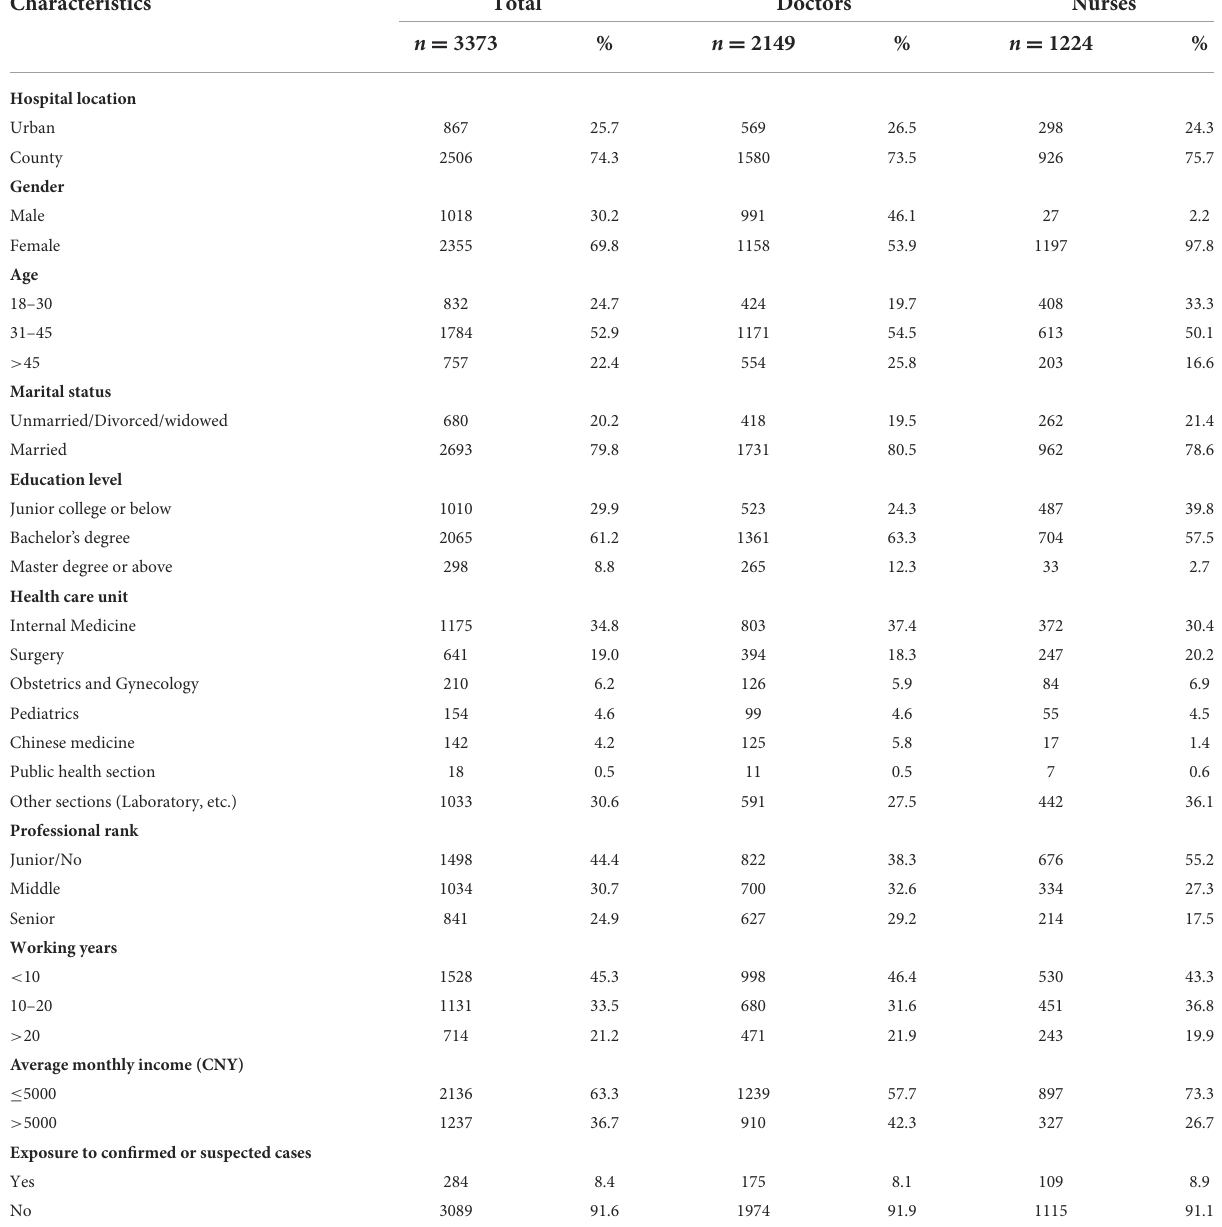
TABLE 1 Sociodemographic characteristics of study